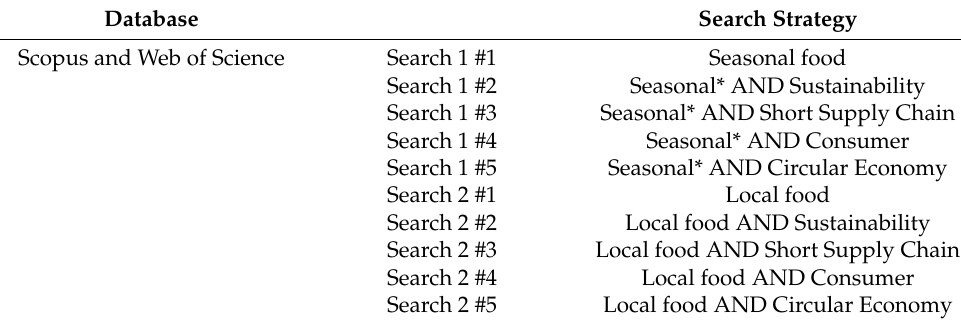
Table 1. Search strategy with presentation of the keywords used to evaluate information about seasonal and local food. The symbol “*” broadens a search for finding words that start with the same letters, such as